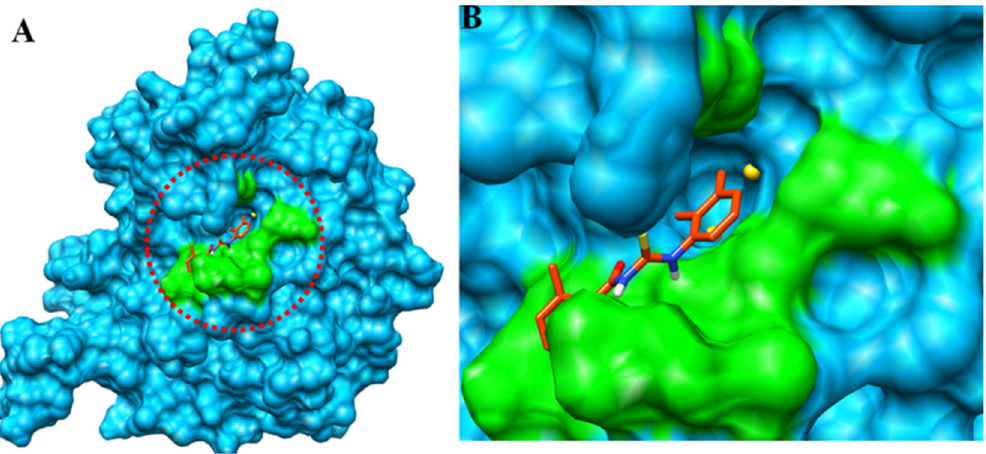
Figure 5. ( A , B ) Binding Pocket analysis of 4i against urease